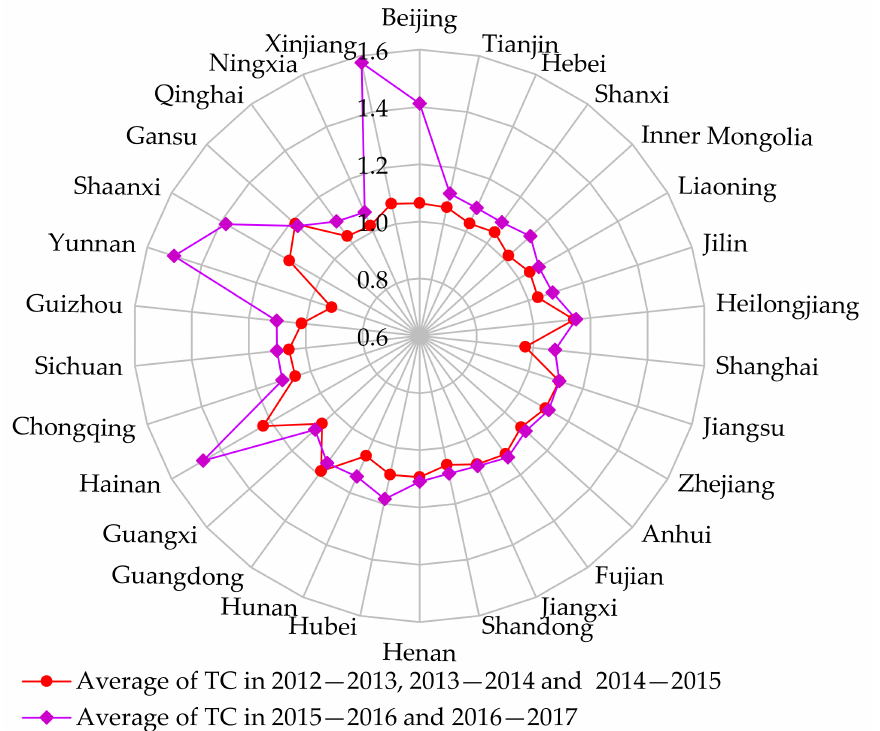
Figure 8. The change in production technology (TC) of the industrial sector in various provinces from